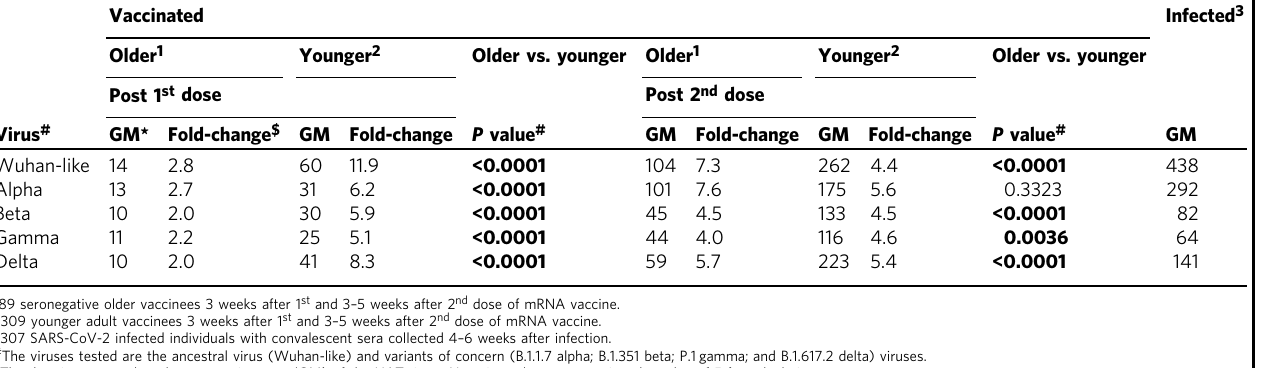
Table 4 The haemagglutination test (HAT) antibody response to the Wuhan-like virus and variants of concern after one and two doses of mRNA vaccine and after SARS-CoV-2 infection in seronegative younger and older